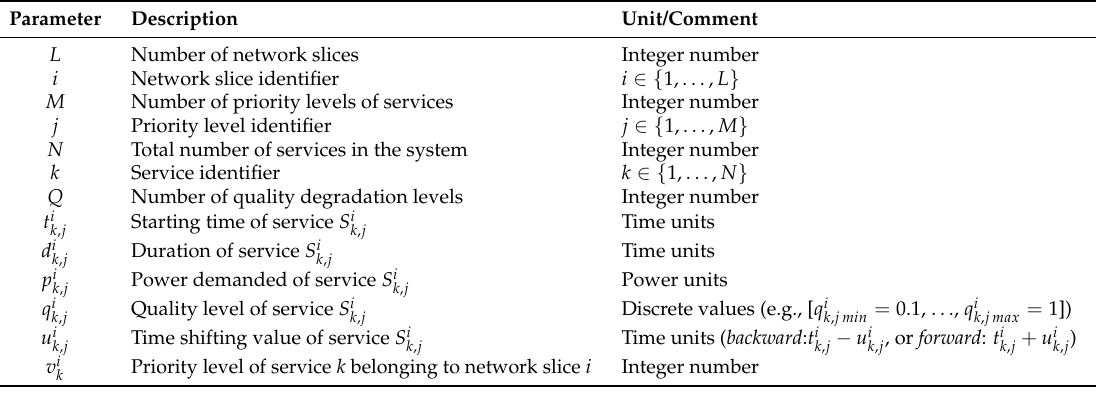
Table 5. Parameters of network slices and services.